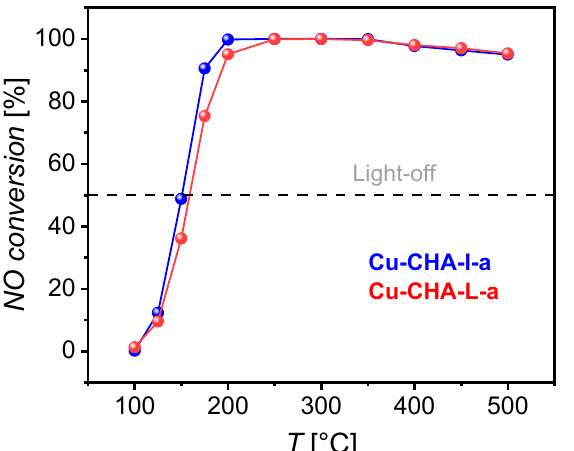
Figure 4. NO conversion, under NH 3 -SCR conditions, of Cu-CHA-I-a (blue) and Cu CHA-L-a (red).